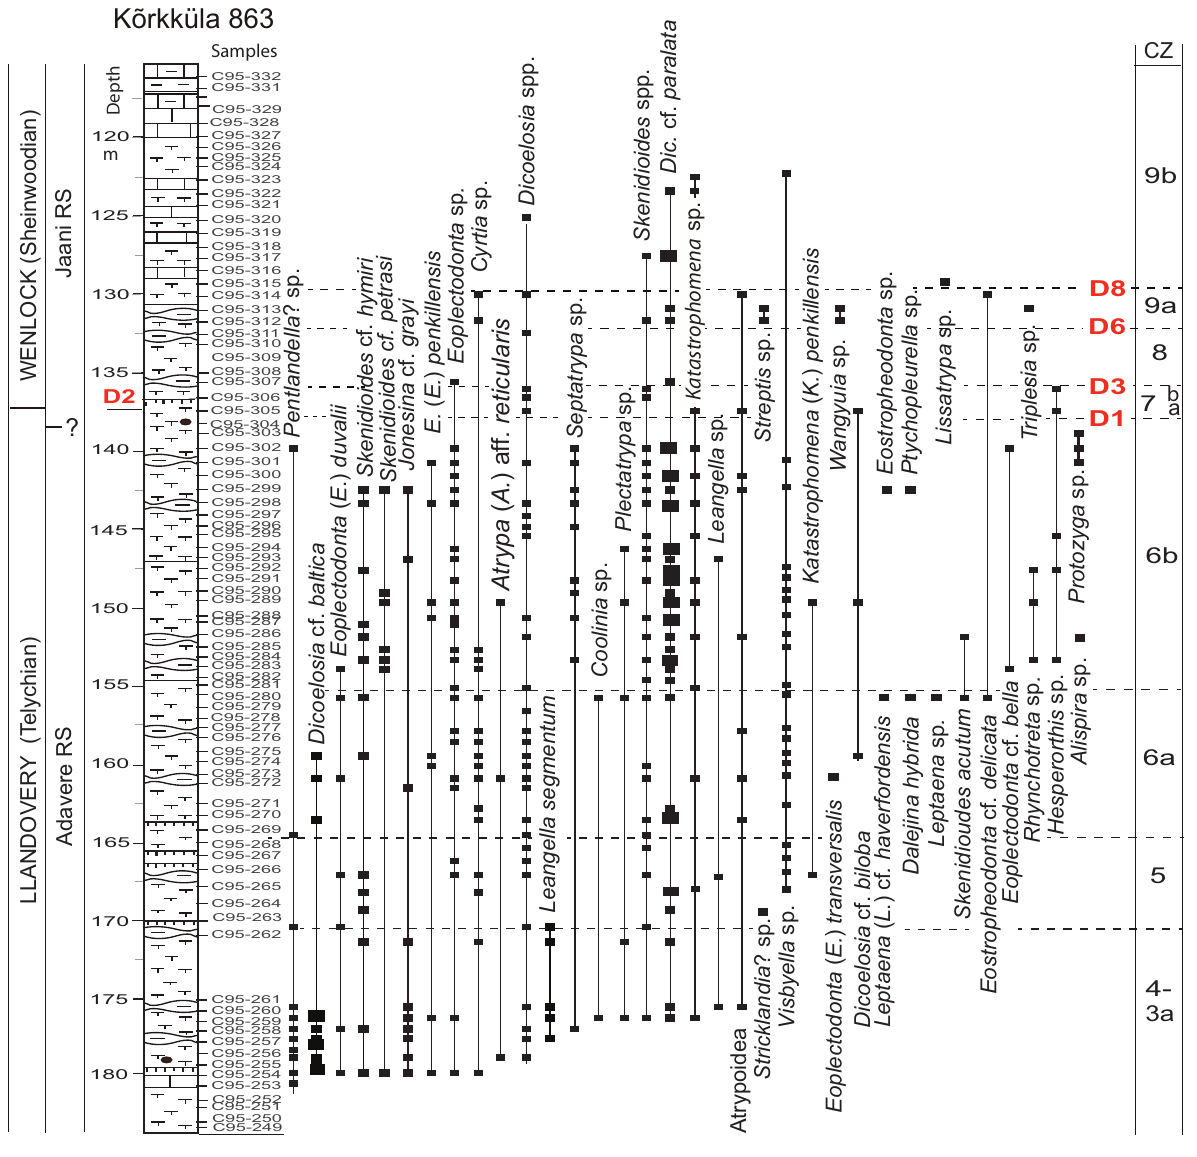
Fig. 5 . Distribution of brachiopods in the Kõrkküla 863 section. For the legend and explanation of indexes, see Figs 2 and 3. Larger rectangles mark more than one specimen in